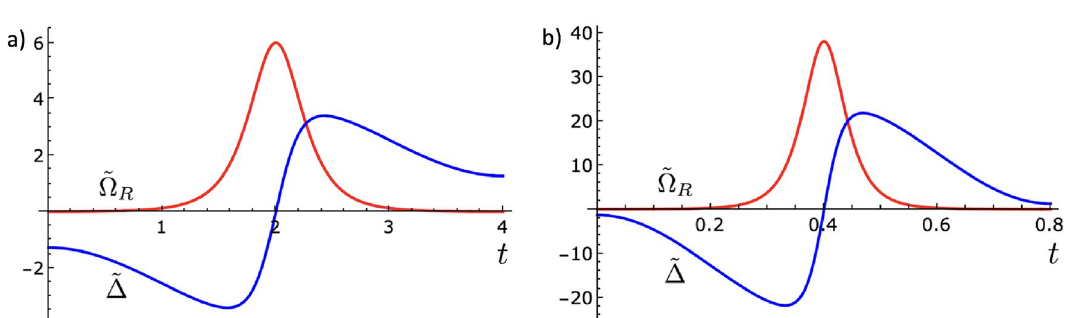
Figure 1. Time behavior of: ( a ) (cid:31) R and (cid:31) for the AE adiabatic passage scheme as described in Eqs. (12) and (13), and ( b ) the populations of the energy levels with the initial state given by 2 , β 1 . √ 2 , and t 0 (cid:31) 0 = = =